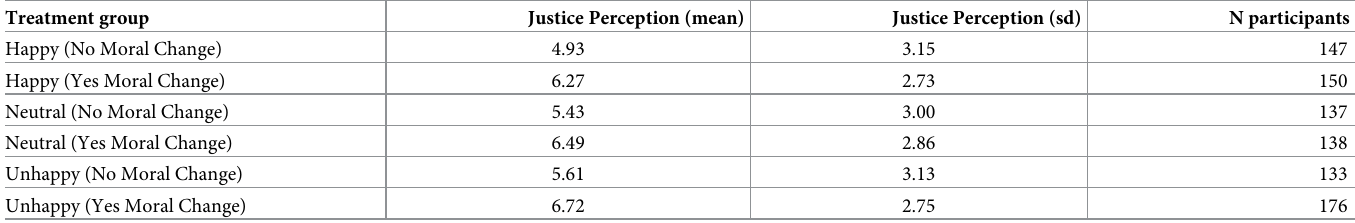
Table 3. Mean perceived justice across treatment levels.